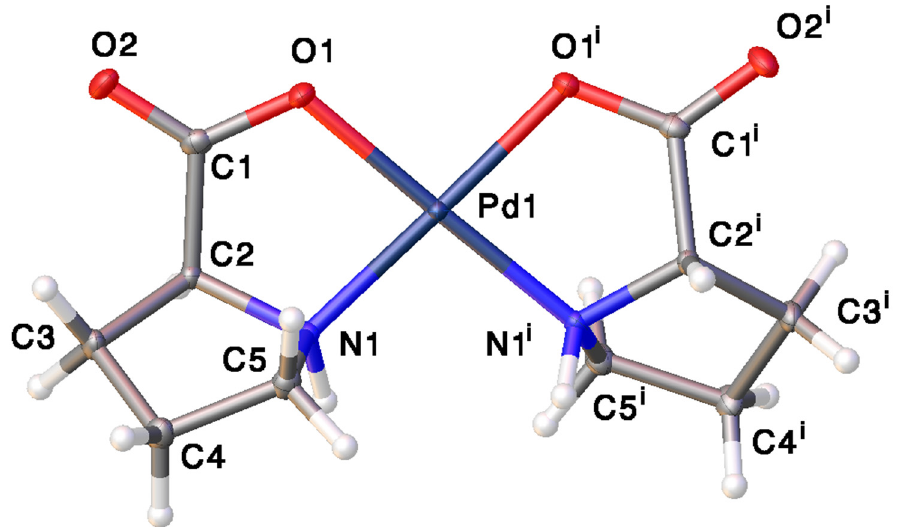
Figure 3. Thermal ellipsoid plot of the molecular structure of crystalline cis -bis(L-prolinato)palladium(II), 1 . Atoms labelled “i” are generated by a C 2 rotation. Thermal ellipsoids are shown at the 50% probability level. CCDC:1913626.